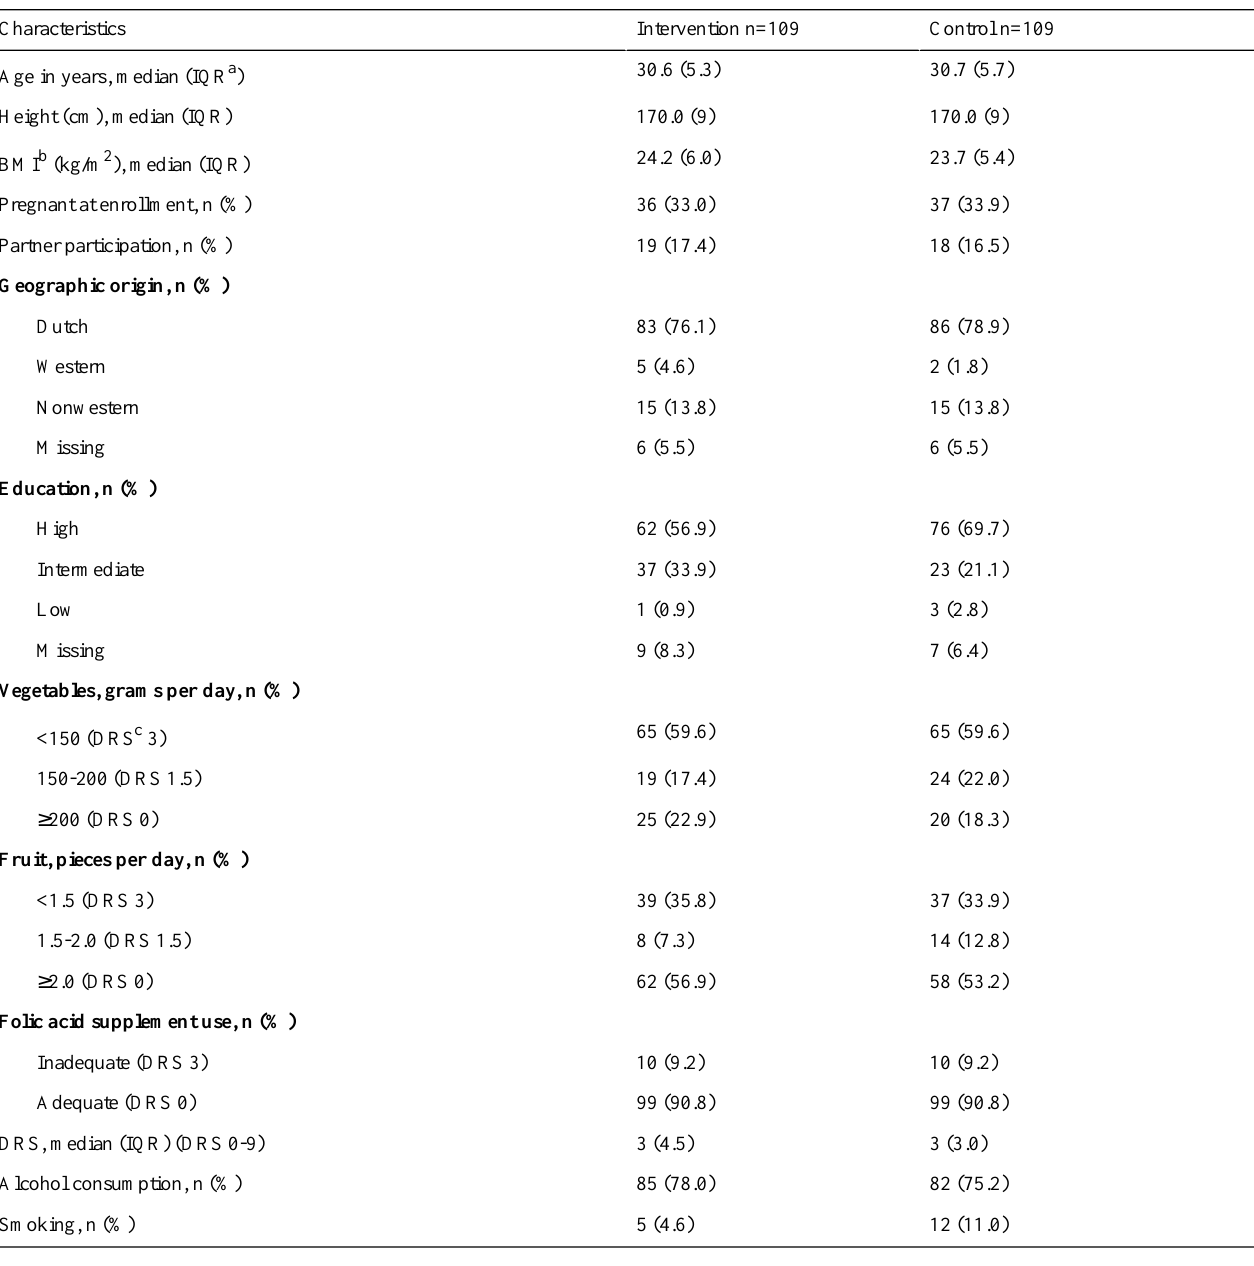
Table 1. Baseline characteristics of all women in the intervention and control groups.